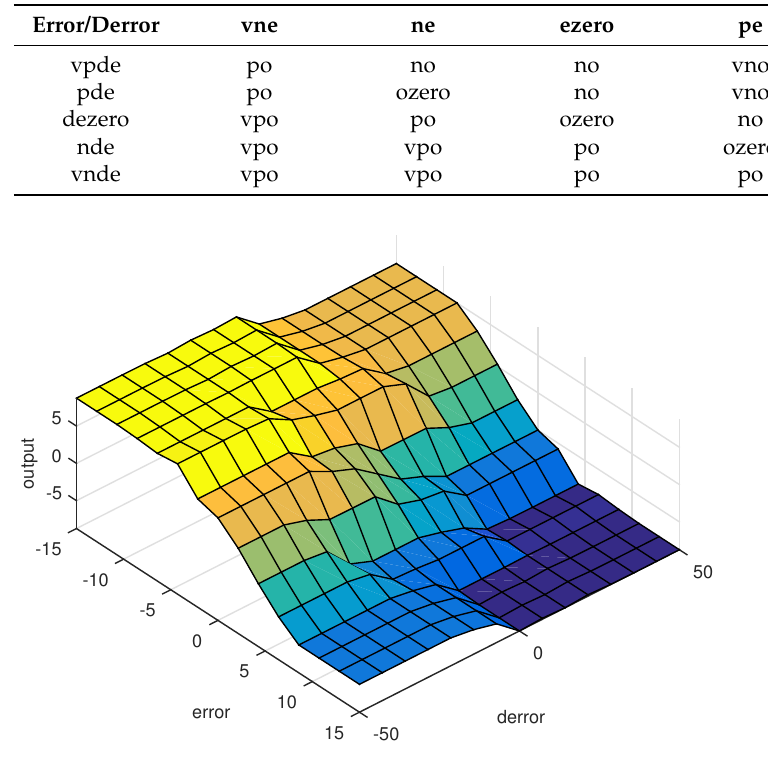
Figure 5. Proposed fuzzy control surface.